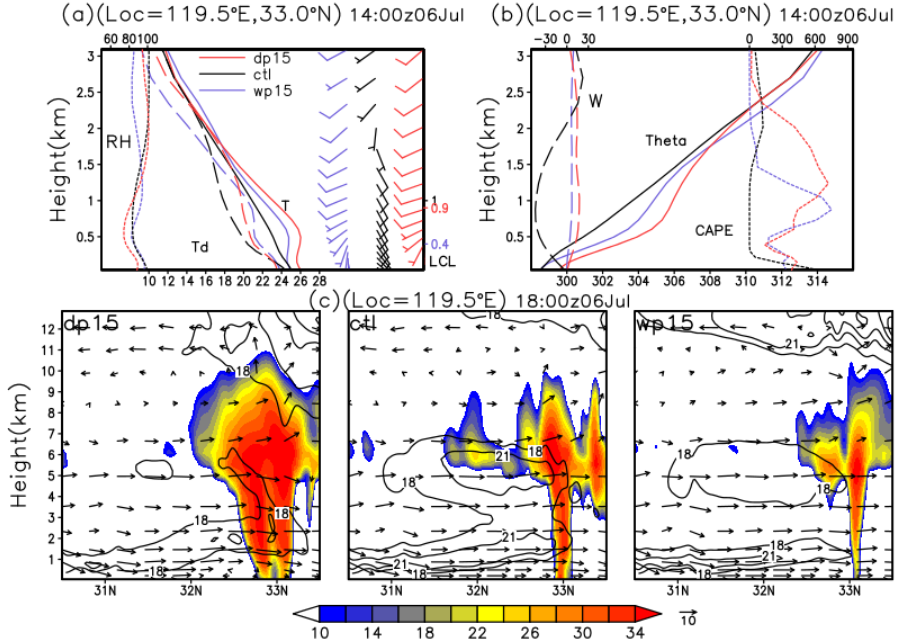
Figure 14. Comparison of the 0~3 km PBL characteristic profiles at 2 p.m. UTC on 6 July and the mature TUSs at 6 p.m. UTC on 6 July. ( a ) Temperature (solid line; units: °C), dew point (dashed line; units: °C), relative humidity (dotted line; units: %), LCL (units: km) and winds are plotted in a full barb of 4 m ⋅ s −1 ; ( b ) Potential temperature (solid line; units: k), vertical velocity (dashed line; units: m∙s −1 ) and CAPE (dotted line; units: J∙kg −1 ); ( c ) Height-longitude cross-section of a wind velocity greater than 16 m ⋅ s −1 , radar reflectivity (shaded; units: dbz) and vertical wind vectors (v, w) along 119.5°E. In ( c ), units of v are m ⋅ s −1 and units of w are 10 −1 m ⋅ s −1 .